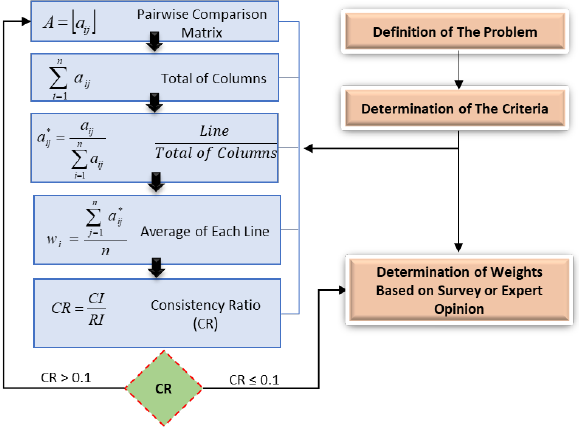
Figure 1. AHP method process flow diagram